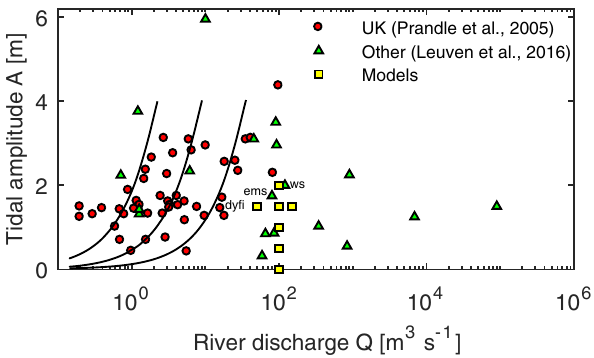
Figure 12. Tidal amplitude plotted against river discharge for real- world estuaries and modelled scenarios. Field data are used from Prandle et al. (2005) for estuaries in the UK and several other sources for different estuaries over the world. Lines indicate esti- mations of estuarine length by Prandle et al. (2005) of 5, 10 and 20km from left to right.